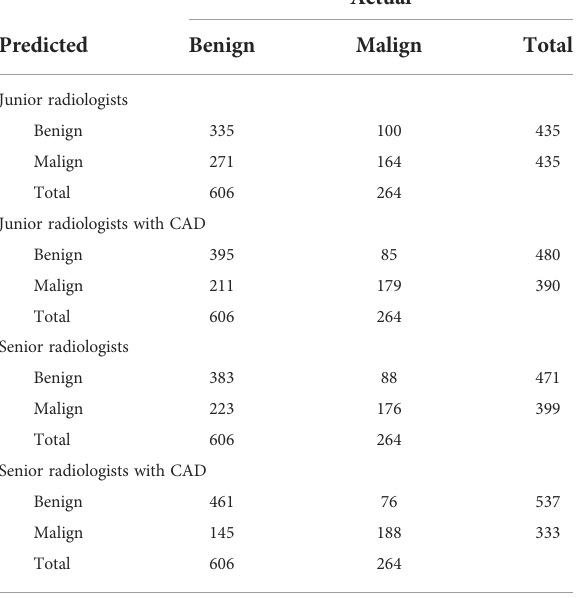
TABLE 8 Confusion matrices between radiologists of different level on the unbalanced data